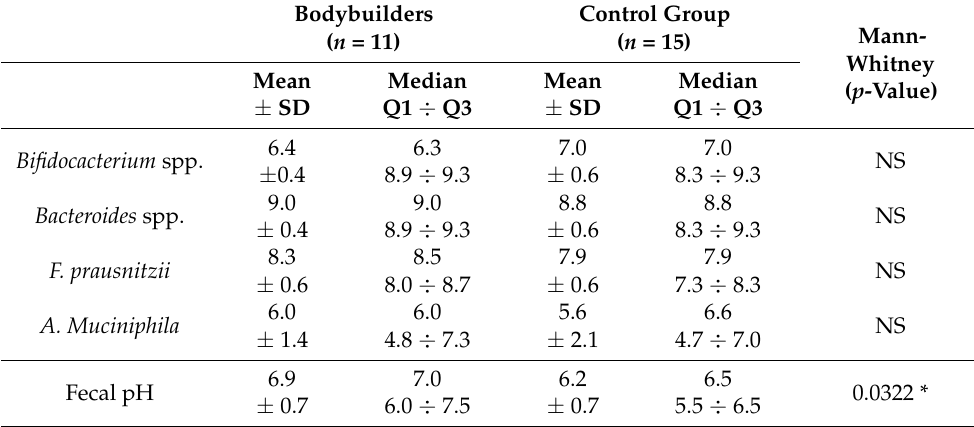
Table 6. Comparison of the targeted stool bacteria and fecal pH values of bodybuilders and the control group.